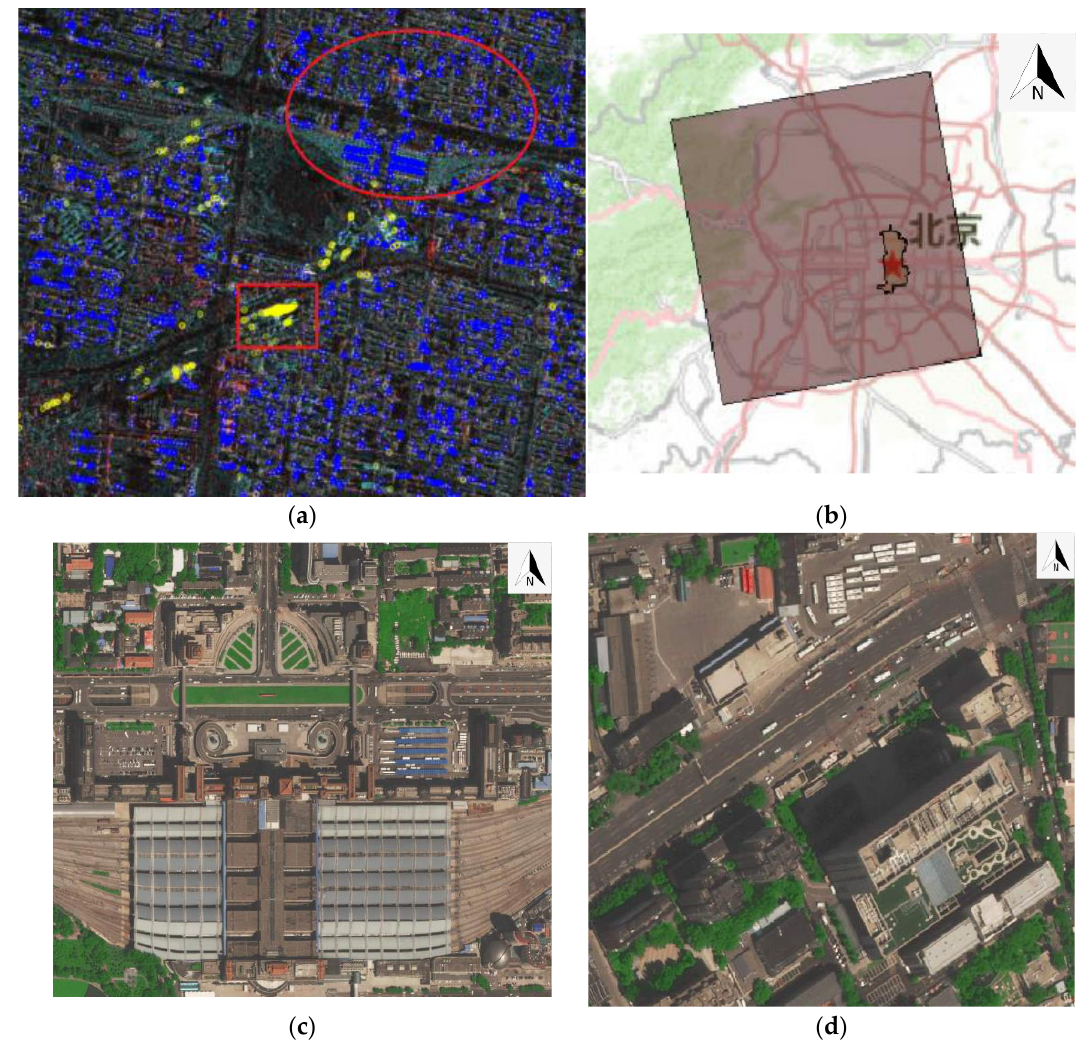
Figure 8. ( a ): The local area in the Beijing scene. ( b ) The geographic location projection of the scene on the map (text in the picture is Beijing); ( c ) a Google optical image of the Beijing West Railway Station and the nearby buildings, corresponding to the area circled in figure ( a ). ( d ) A Google optical image of the Beijing Electric Power Hospital building, corresponding to the yellow-marked targets framed in figure ( a ).